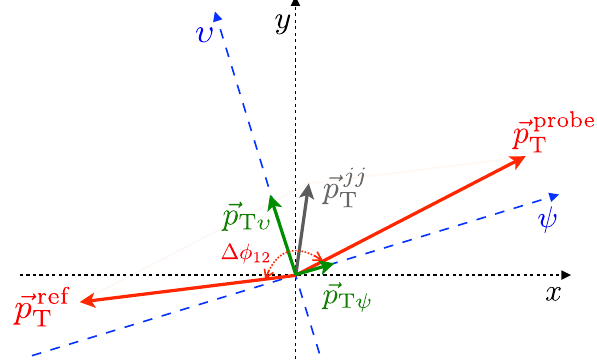
Fig. 15 Illustration of observables used in the dijet bisector technique. The (ψ,υ) -coordinate system is defined such that the υ -axis bisects the azimuthal angle (cid:8)φ 12 between the leading two jets while the ψ -axis minimizes the angle to the probe jet. The vectorial sum of the transverse momenta of the probe and the reference jets define the dijet transverse momentum p jj . Its components along the ψ - and υ -axes ( p T ψ and T p T υ ) are used to extract a measurement of the jet energy